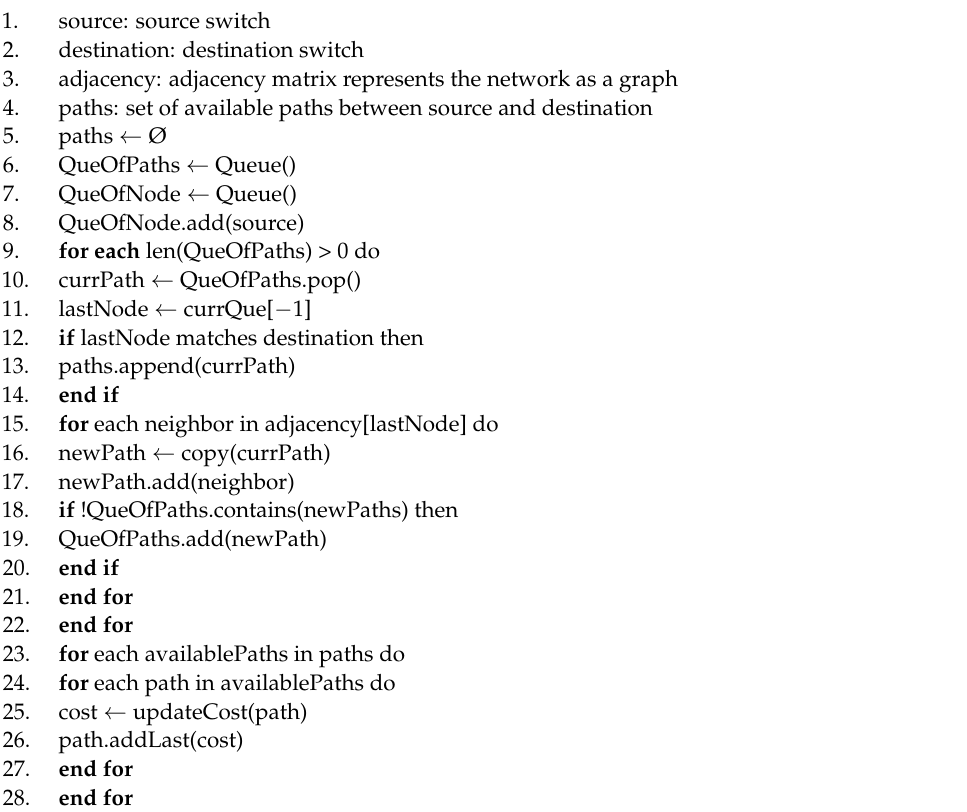
Algorithm 2 Find all Available paths between two Switches